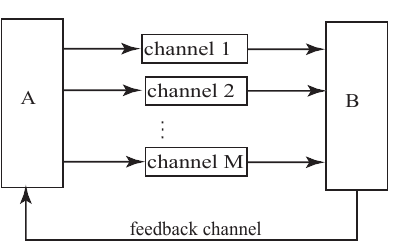
Figure 1. Multichannel Communication